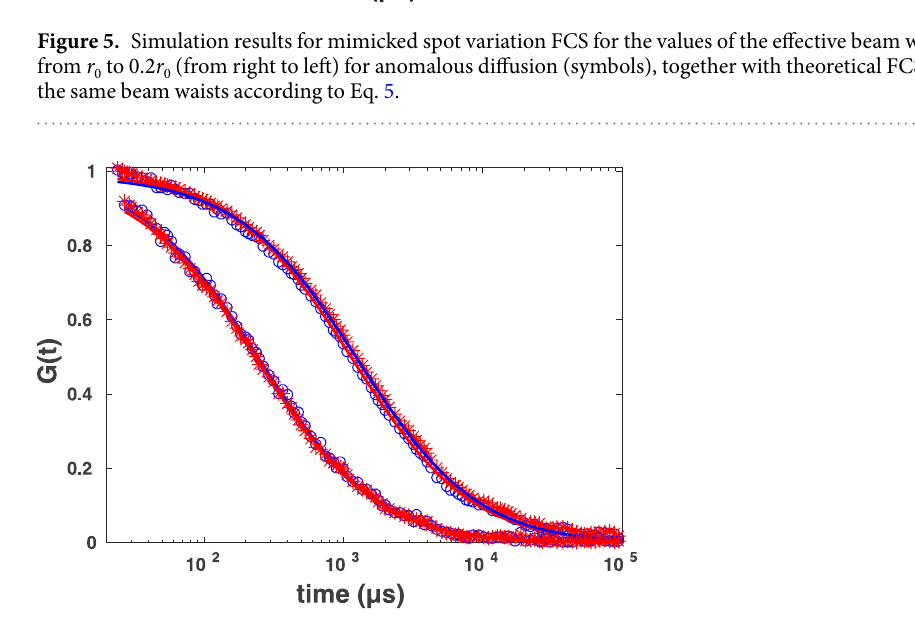
molecule FCS measurement, one should observe strong fluctuations of count rates arising from entering and exiting the tracers. In our experiments, the photon count rate in background was roughly 1,000 cps and changes to maximum roughly 10,000 cps depending on the trajectories intersecting different parts of confocal volume. To filter out the unwanted background photons coming from reflection, time gating was used. Autocorrelation functions for the corresponding cases calculated from recorded photon counts and from the restored intensity profiles according to Eq. 9 with σ = 3 μ s are shown in Fig. 6. The fit for the case of crowded buffer with 30% PEG1500 led to the exponent of anomalous diffusion and diffusion time being 0.89 ± 0.03 and 1,084.3 ± 38.6 μ s . The case of diffusion in pure buffer solution were fitted to the normal diffusion and resulted in diffusion time being 243 ± 20 μ s. The differences between fits to original FCS data and reconstructed ones using kernel smoothing method for both normal and anomalous diffusion were very small and here we reported the fit for smoothed curves. The standard deviations were calculated from N = 6 repeated experiments for both. To avoid considering the photophysics of AlexaFluor647 dyes, only lag times longer than 20 μ s were taken into account in the analysis of the FCS curves. However, since the diffusion processes are slow, this does not impact our analysis significantly. Note that this lag time is of the order of the time limitation of our method as defined by the value σ used. Similar to our simulations in the previous section, the FCS autocorrelation functions as calculated from the photon counts and from the restored intensity traces coincide (compare blue and red solid lines in Fig. 6). To investigate the binning method, original binary photon counts were also binned with a bin width of 10 μ s, which results in an intensity profile varying from zero to maximum of 20 and 31 counts for normal and anom- alous diffusion, respectively. Having both intensity traces at hand, we could apply the nonlinear transformation